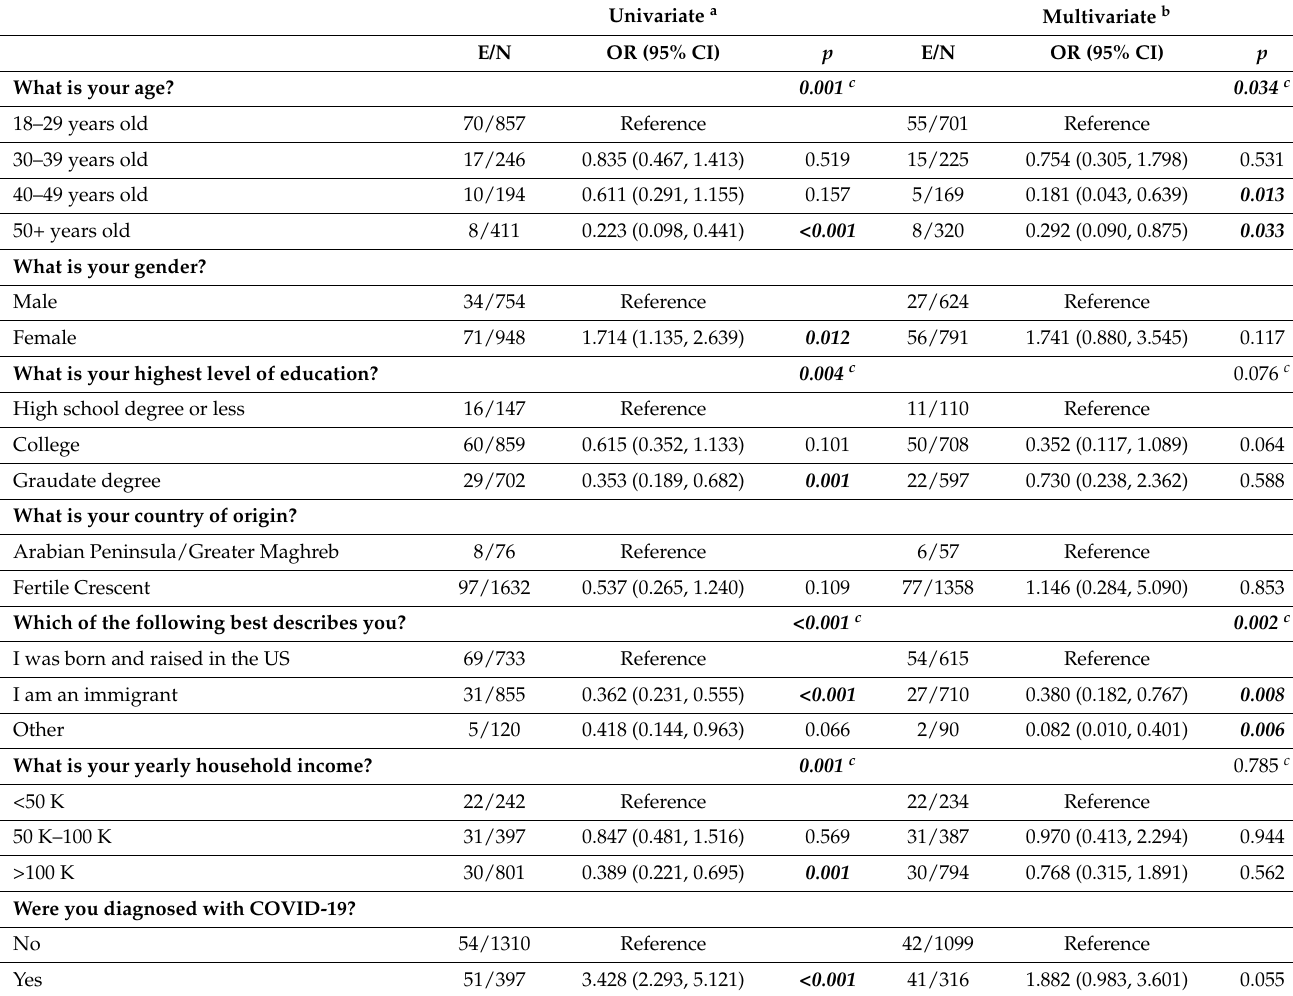
Table 4. Univariate and multivariate logistic analyses of risk factors associated with vaccine hesitancy (Yes vs. No, No as